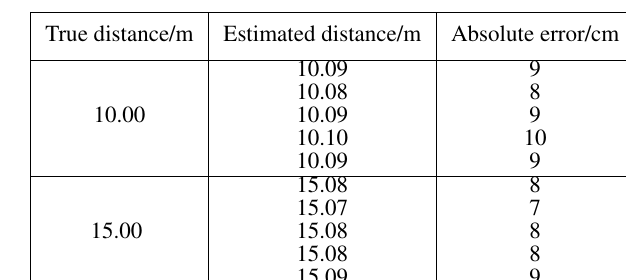
Table 1. Parameters of DSSS modulation.